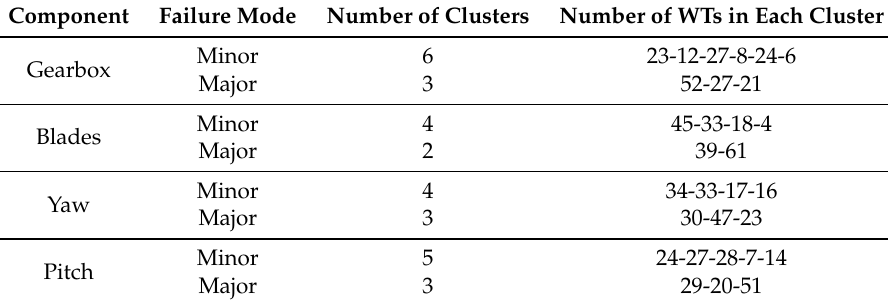
Table 3. Clusterization results.